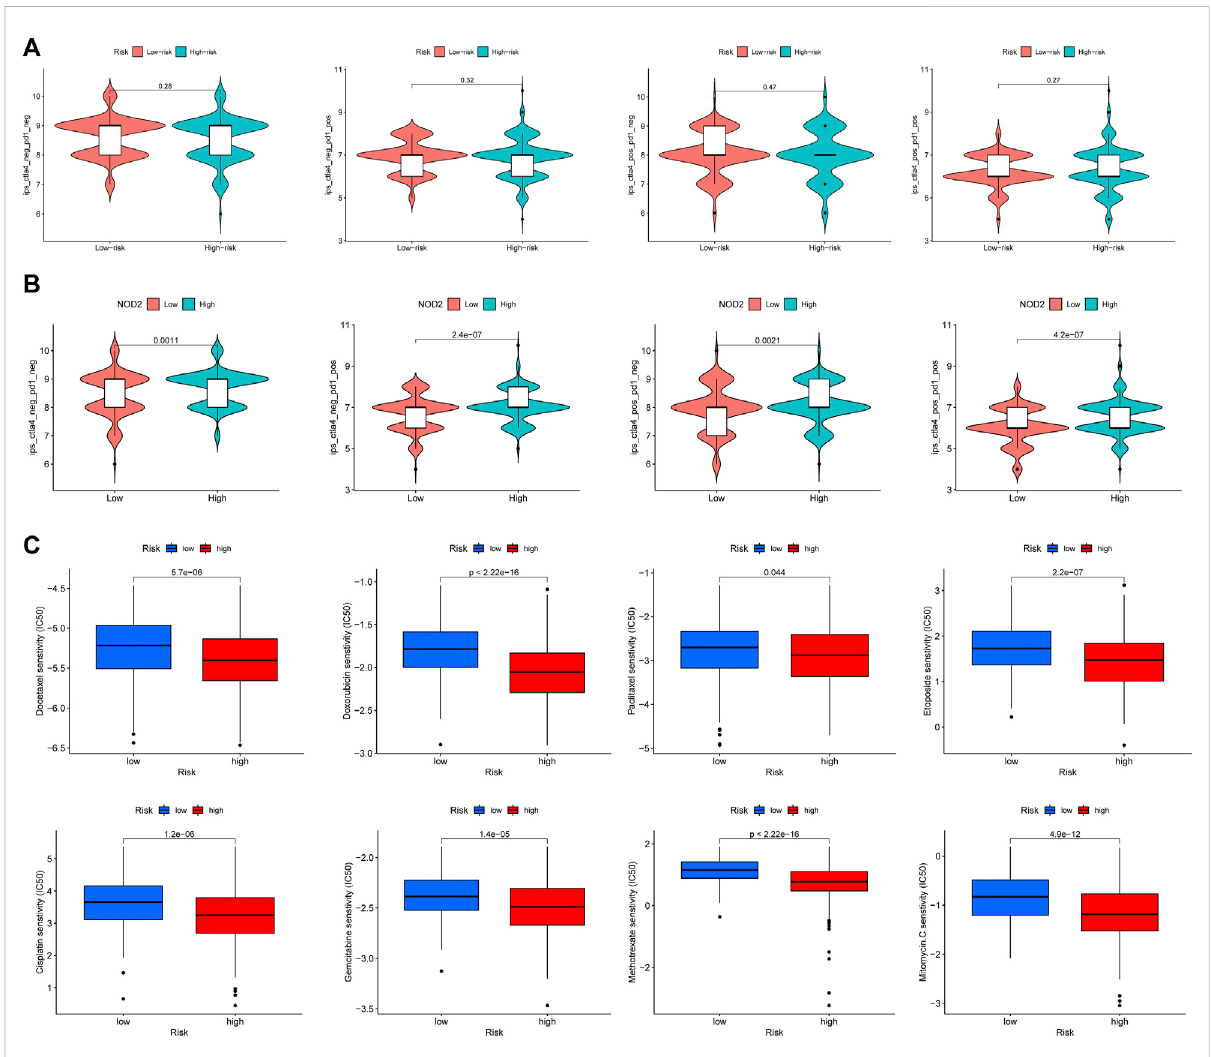
FIGURE 14 The responses to immunotherapy and chemotherapy. (A) The Violin plots of immunotherapy response between high and low risk groups. (B) The patients with high NOD2 expression were more sensitive to immunotherapy. (C) The estimated IC50 of common cell cycle-related chemotherapeutic agents between high and low risk